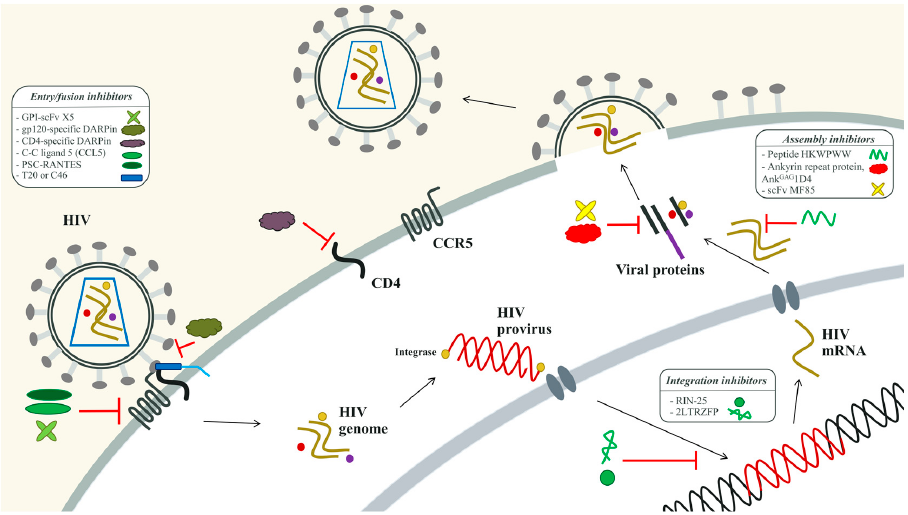
Figure 1. Summary of functional sites of anti-HIV peptide and protein inhibitors at different stages of the HIV-1 life cycle. For further details please refer to the text.